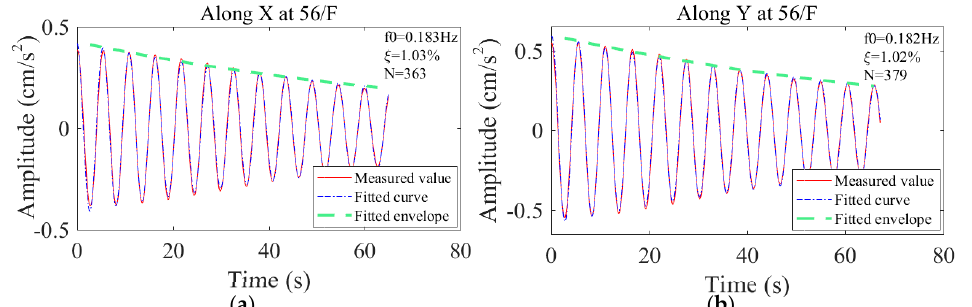
Figure 10. Typical random decrement (RD) signatures and estimation of natural frequency and damping ratio for first swaying mode at the 56th floor (N: sample number involved in RD signature). ( a ) Along X; ( b ) Along Y.